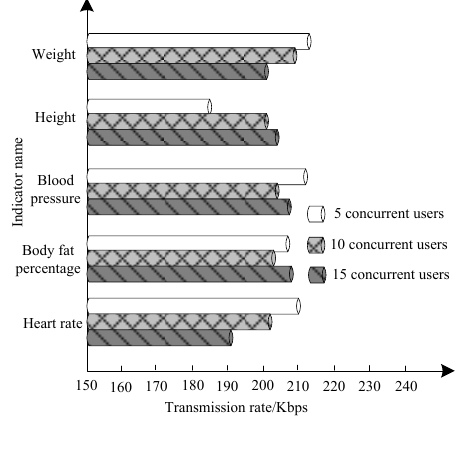
Figure 7. Data transmission speed of telemedicine monitoring